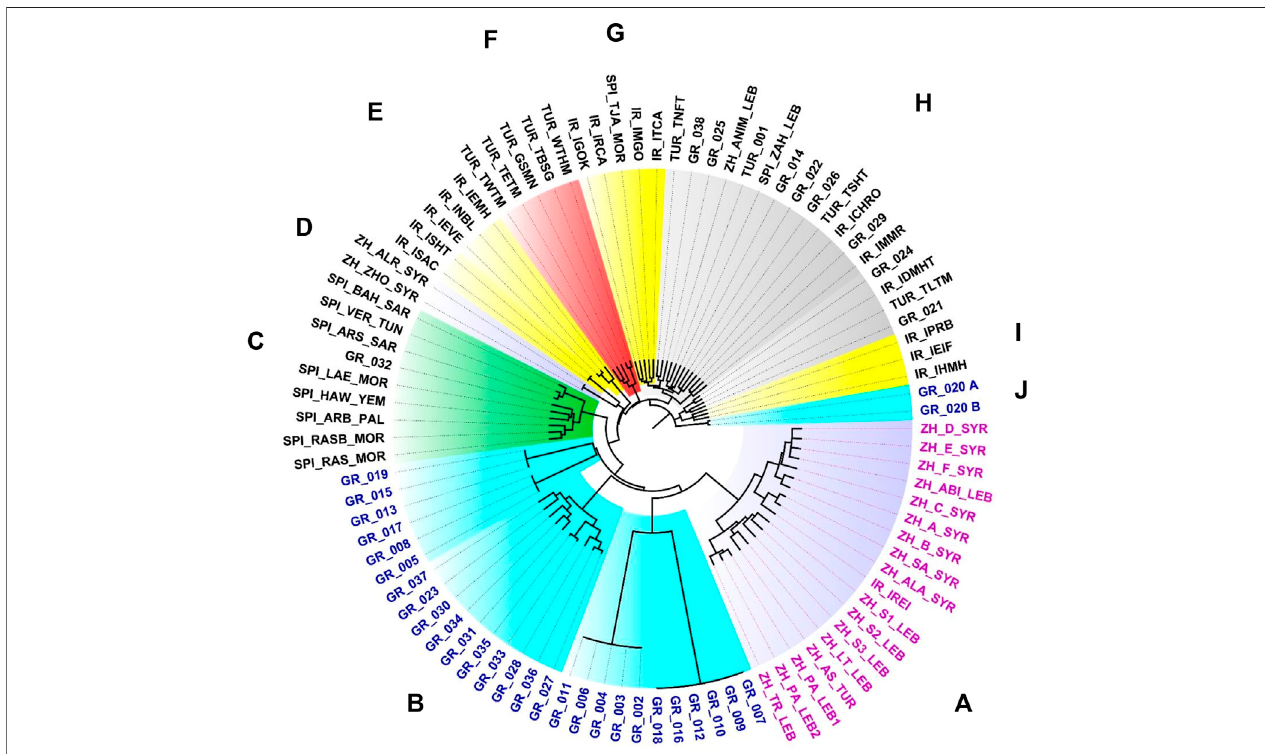
FIGURE 4 | Ward ’ s minimum variance tree with geographical clusters of herbal tea samples. A, “ Zhourat ” from Lebanon and Syria; B, Main group of Greek herbal mixtures;C,SamplesofArabianstylespicemixtures;D,Abnormallypooriningredients “ zhourat ” commercialsamples;E,Iraniansamplesextremelypooriningredients, but with Echium amoenum Fisch. and C.A.Mey., fl owers; F, Turkish samples with cinnamon bark, Hibiscus sabdariffa , and ginger; G, Iranian samples with, among others, Thymus vulgaris L. and Lavandula angustifolia Mill.; H, samples of different origins with no regional differential markers; I, Iranian samples with, among others, Citrusaurantiifolia (Christm.)Swinglefruits;J,Complex “ saranda ” mixturefromNaxos,with40ingredients.Abbreviationsforsamplecodes:GR_,Greeksamples; IR_, Iranian; SPI_, spices outgroup; TUR_, Turkish; ZH_, Lebanese and Syrian “ zhourat ” . Image: D. Rivera.